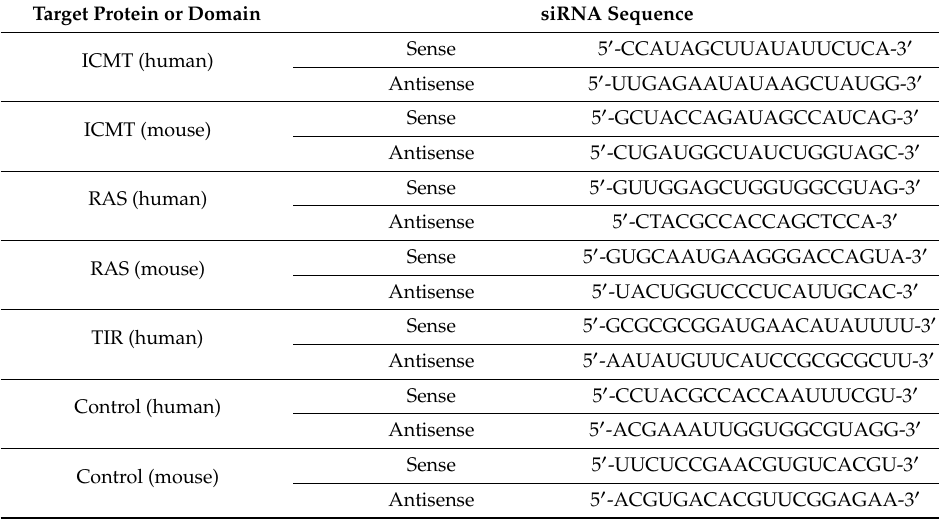
Table 1. siRNA sequences used in this